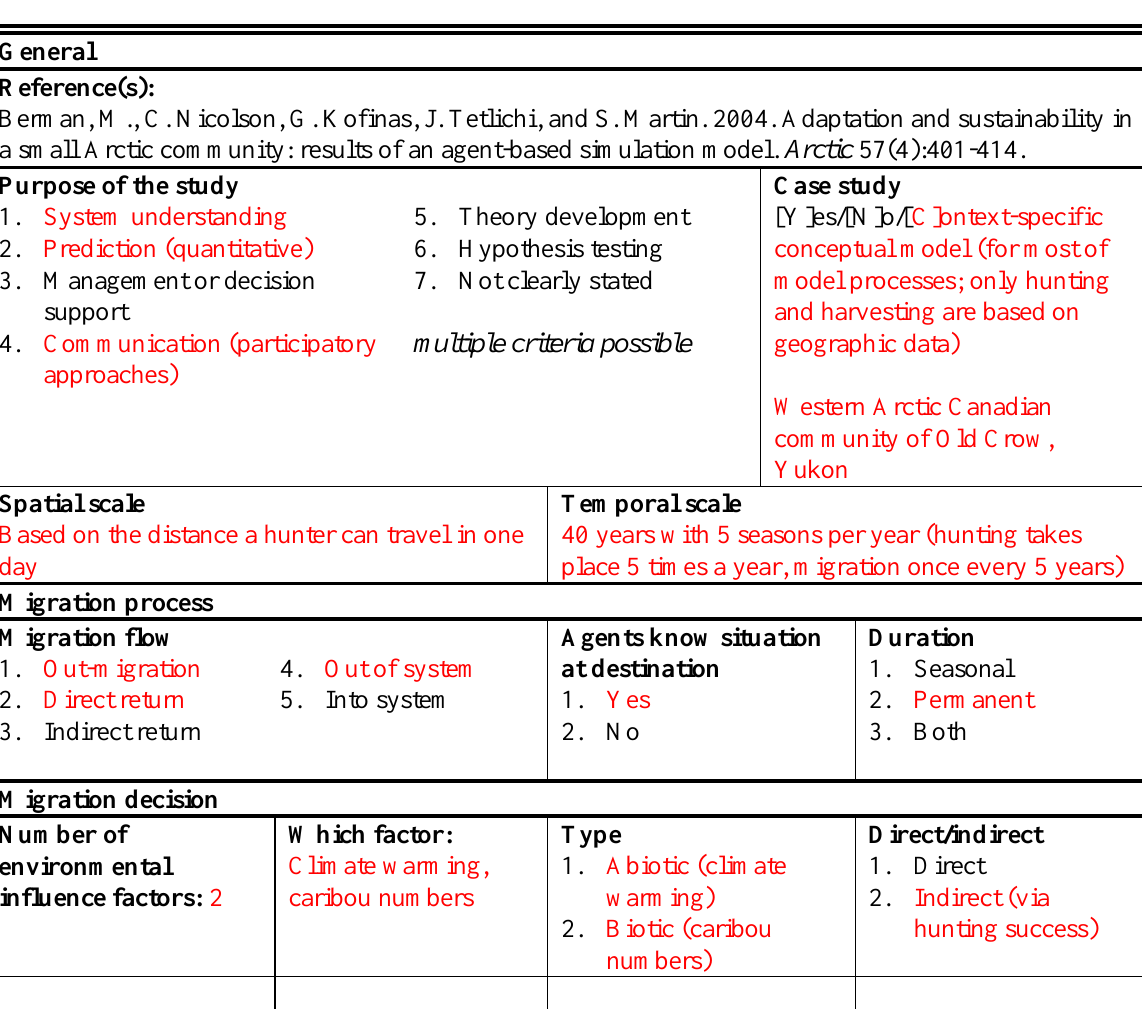
Table A1.1 Standardized protocol for the ABM described by Berman et al.